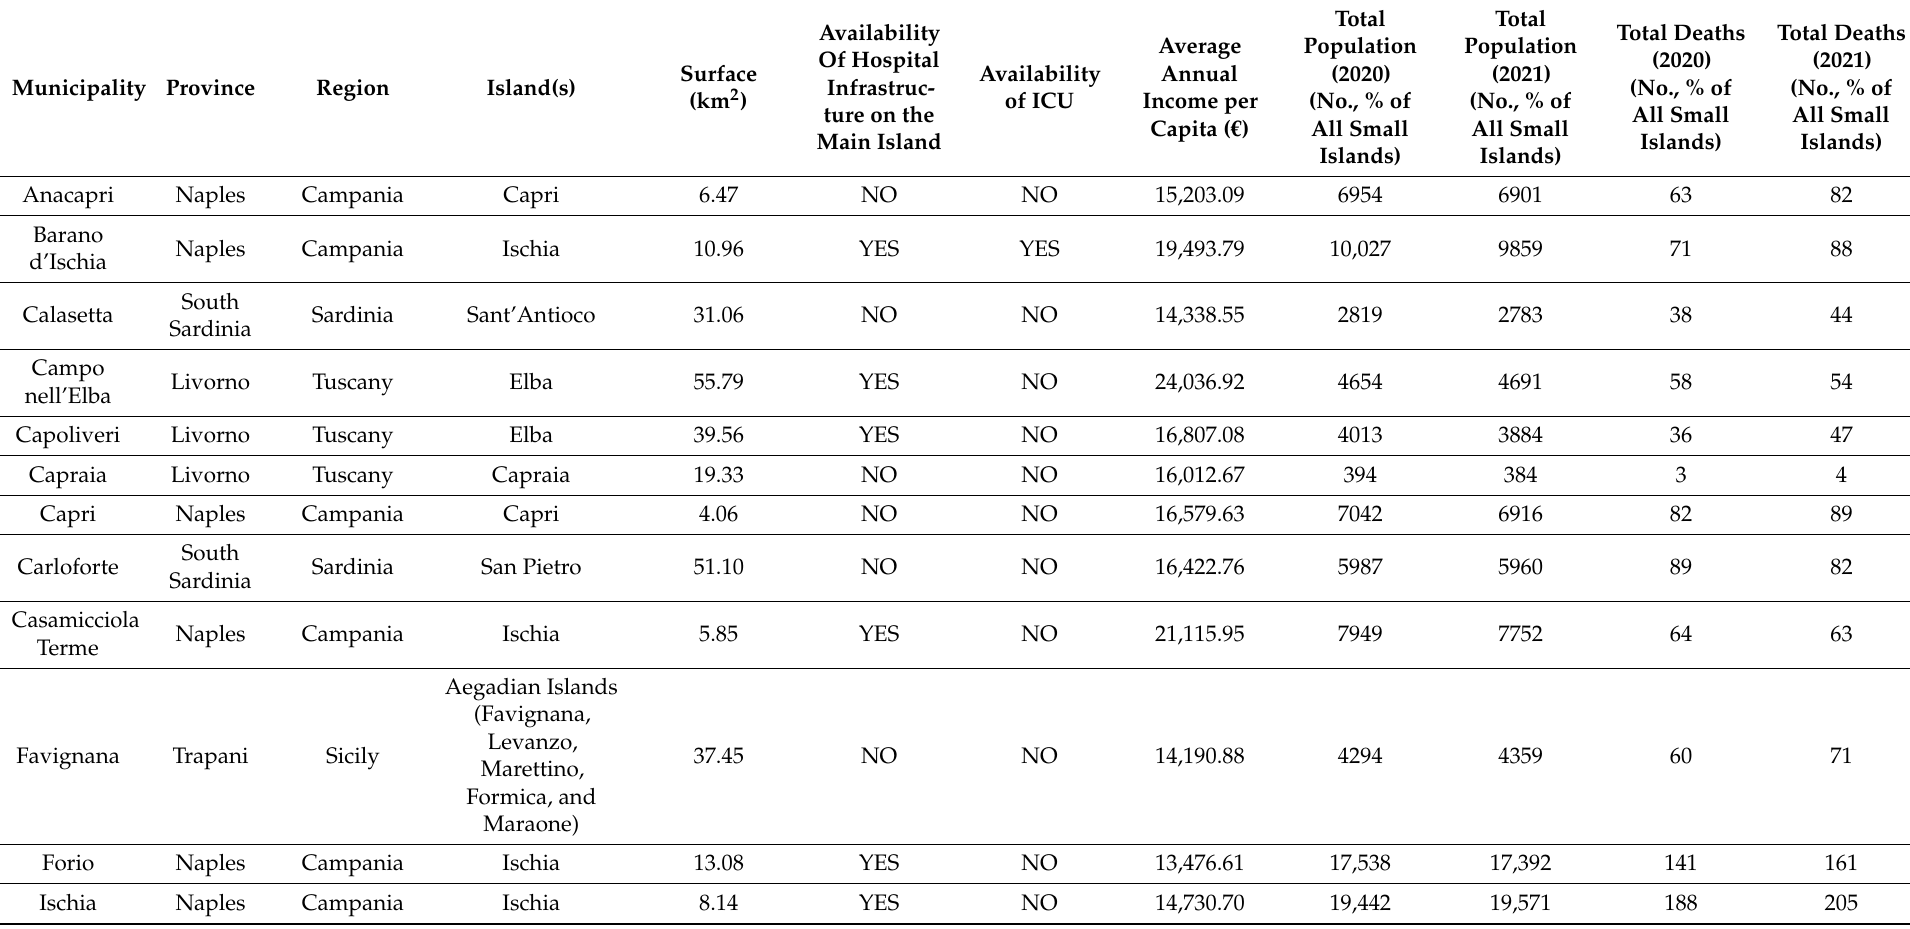
Table A1. Characteristics of 35 municipalities from Italian small